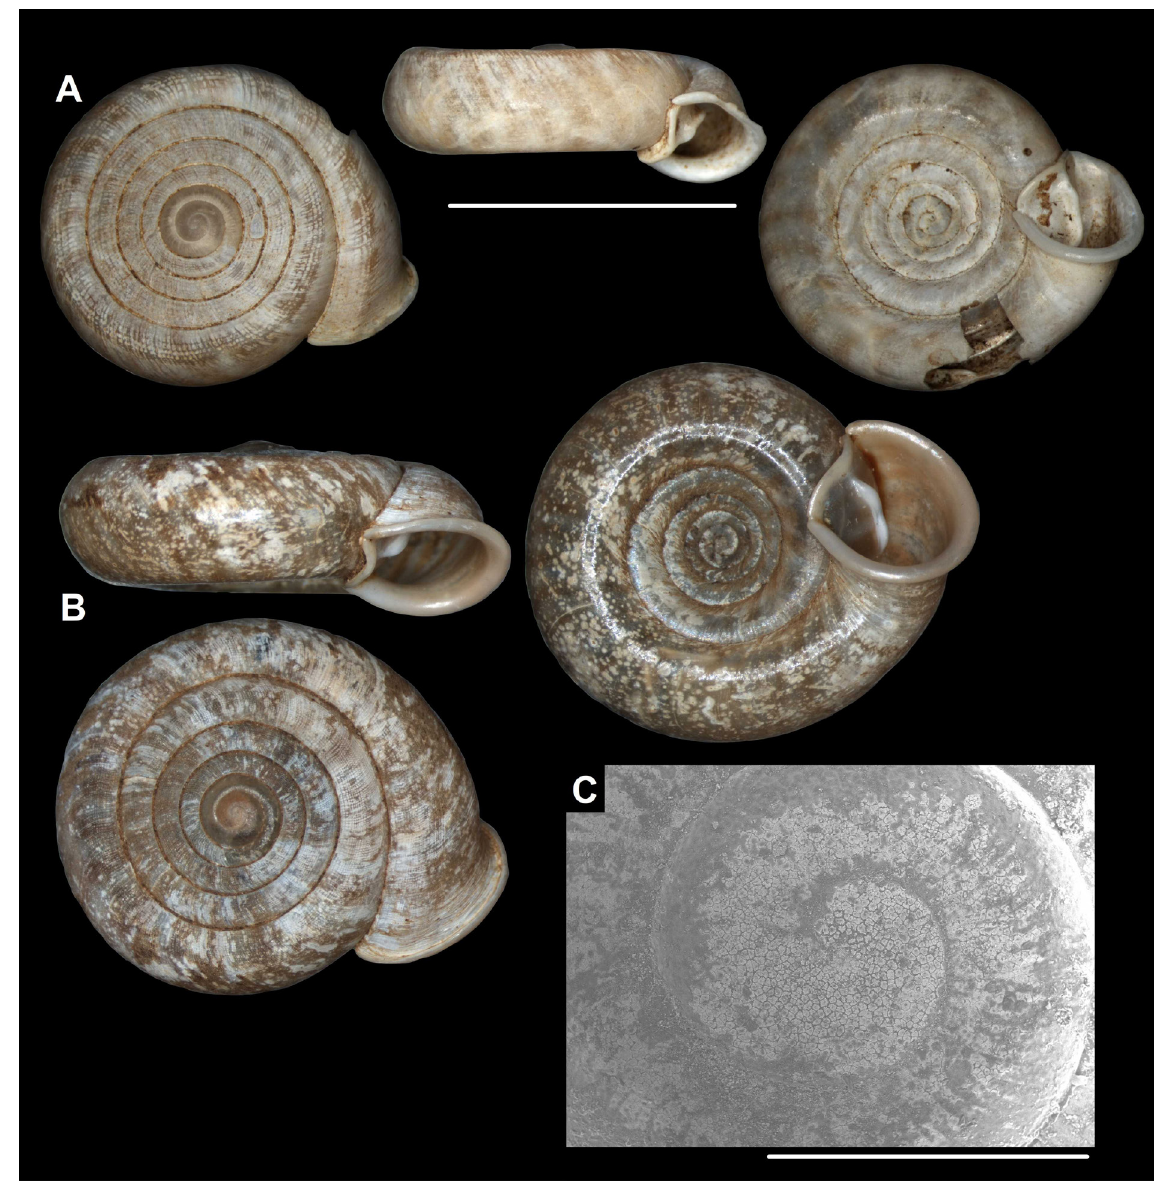
Fig. 8. A . Shell of Chersaecia densegyrata sp. nov., holotype (UF 347223). B–C . Shell and protoconch of C. reversalis sp. nov., holotype (UF 347046). Scale bars: A–B = 10 mm; C = 1 mm. Images: T. Deli (A–B) and B. Páll-Gergely